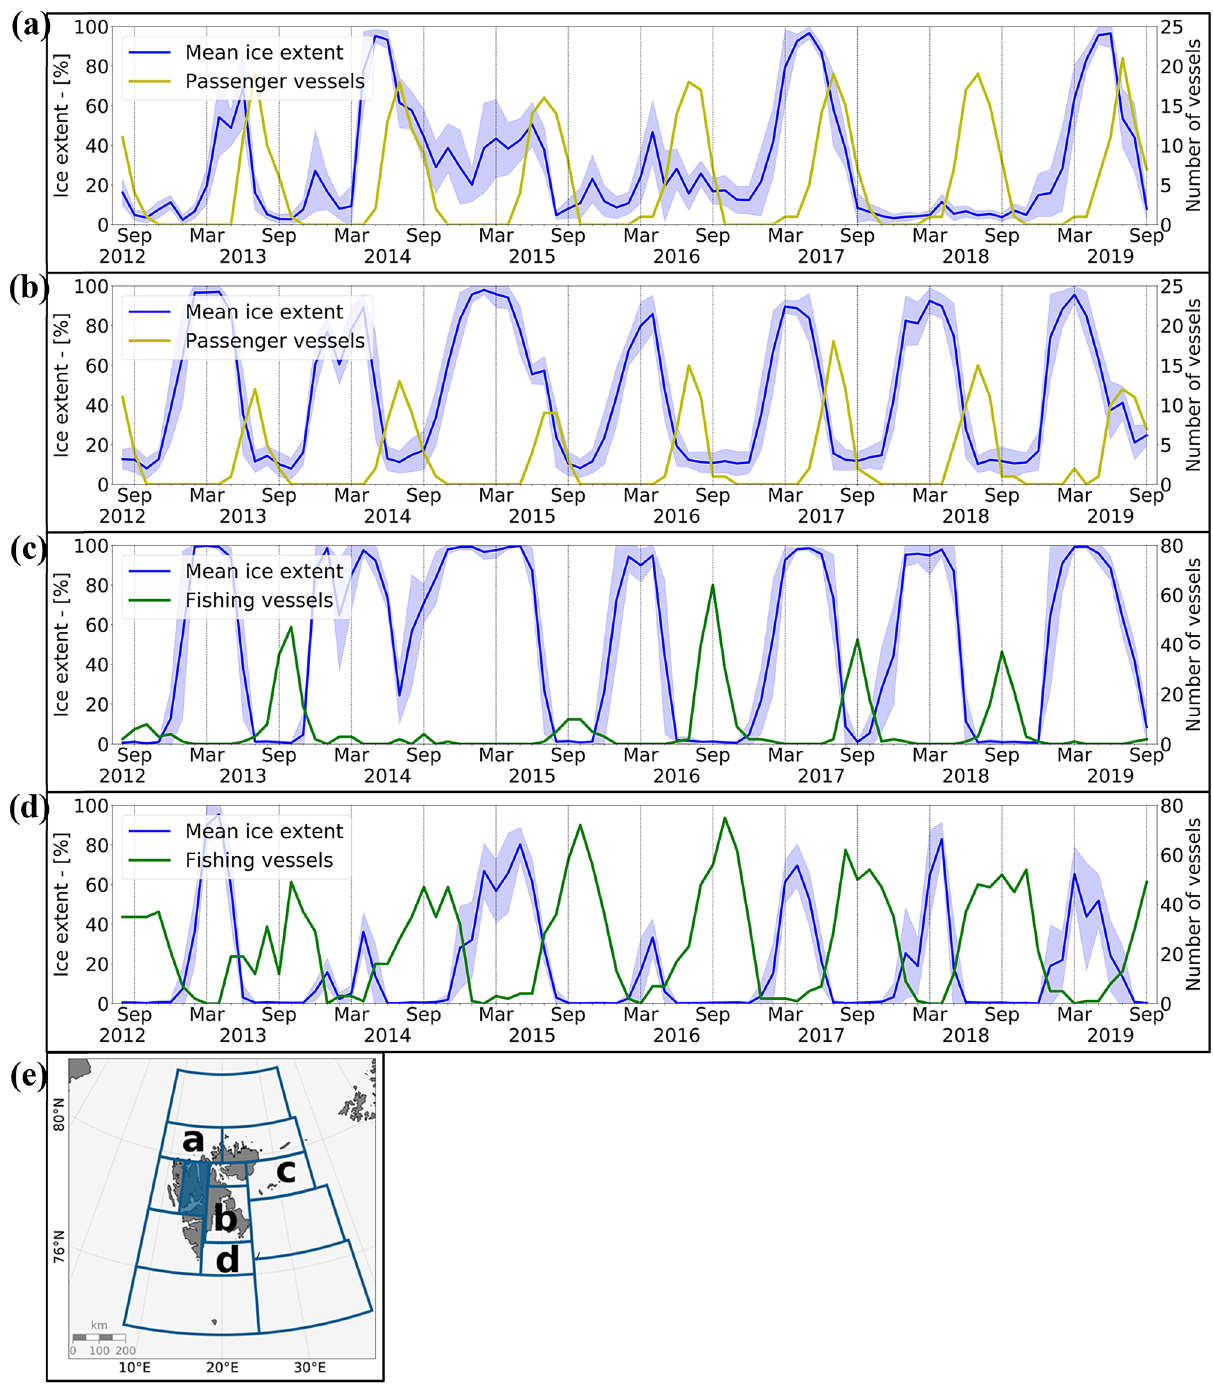
Figure 4. Mean relative sea ice extent, with monthly standard deviation and ( a ) passenger vessels northwest of Svalbard, ( b ) passenger vessels in Storfjorden, ( c ) fishing vessels northeast of Svalbard and ( d ) fishing vessels in Storfjordrenna. ( e ) Map of Svalbard with boundaries of 12 zones, the shaded area was excluded from the analysis due to uncertainty of the sea ice data when in proximity to land. ( a – d ) highlight the location of the time series are shown here. Figures generated with python 3.7.x (https ://www.pytho